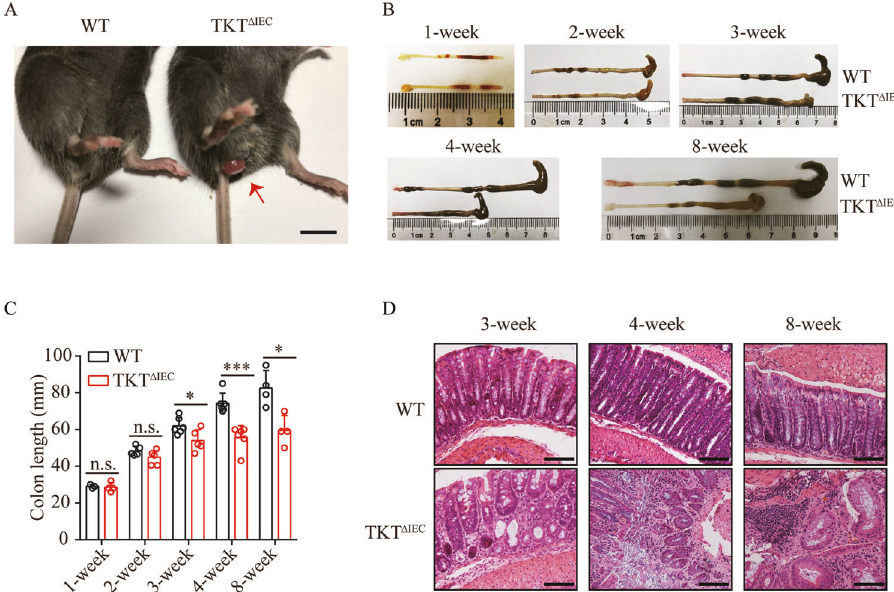
Fig. 2 Loss of TKT in intestinal epithelium induces spontaneous colitis. A TKT Δ IEC mice are more susceptible to rectocele compared with their WT littermates. Scale bars, 1 cm. B Representative images of colons of WT and TKT Δ IEC mice at different ages. C Quanti fi cation of colon length of WTand TKT Δ IEC mice at different ages. D Representative H&E-stained colon sections of WTand TKT Δ IEC mice at different ages. Scale bars, 200 μ